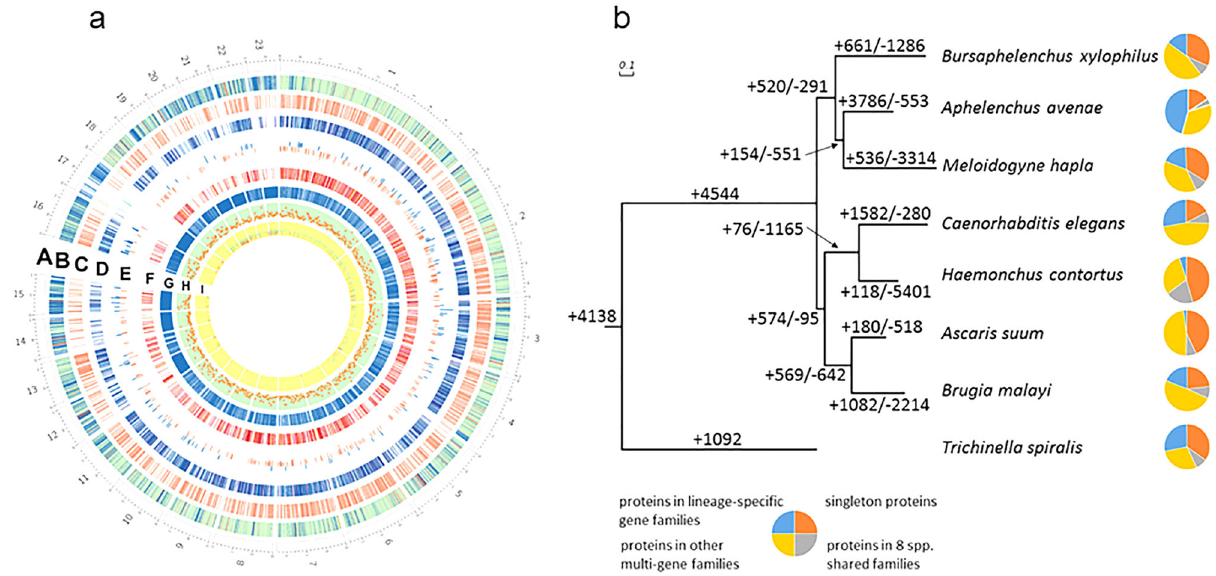
Fig. 1 Genome features of A. avenae genome. a Plots of the largest 23 scaffolds in A. avenae genome. (A) Circular visualization of the largest 23 scaffolds. The axis number stands for the size (Mb) of scaffold span. (B) Gene models on the largest 23 scaffolds in A. avenae genome. Red: conserved genes in A. avenae , C. elegans , B. malayi , M. hapla , A. suum , B. xylophilus , H. contortus , and T. spiralis . Green: additional conserved genes in A. avenae and C. elegans . Blue: unique genes in A. avenae . (C) Predicted operons in A. avenae genome. (D) Heatmap of upregulated genes during desiccation stress in A. avenae . The color represents the FPKM (fragments per kilobase of transcript length per million mapped reads) values. (E) Histogram of above three-fold change upregulated genes (blue) and downregulated (light red) during desiccation in A. avenae . (F) Heatmap of downregulated genes during desiccation in A. avenae . The color represents the FPKM values. (G) Repeats in A. avenae genome (variations per kb). (H) SNP distribution in A. avenae genome. (I) Genome sequencing read coverage (average per 100 bases). Yellow: >100x. Red: <40×. Blue: >40× but <100×. b Gene gains and losses across eight nematode species. The numbers of gene gains ( + ) and losses ( − ) are listed on branches. Singletons or shared genes across the eight nematode species were shown in pie